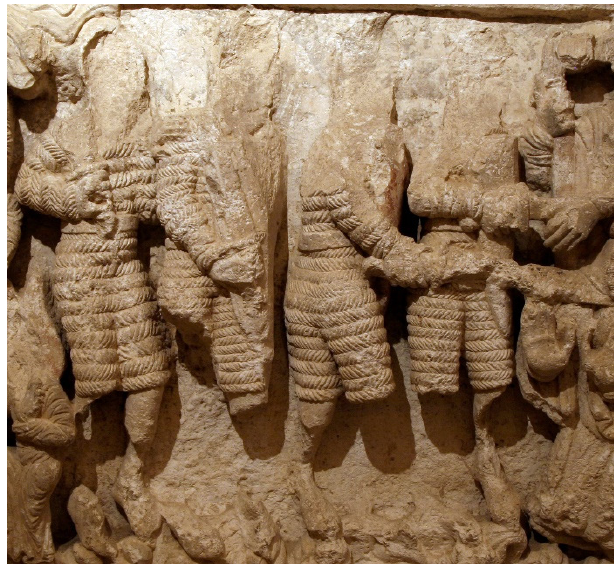
Figure 5. Almazán. Frontal (detail). The four assassins. Figure 5. Almaz á n. Frontal (detail). The four